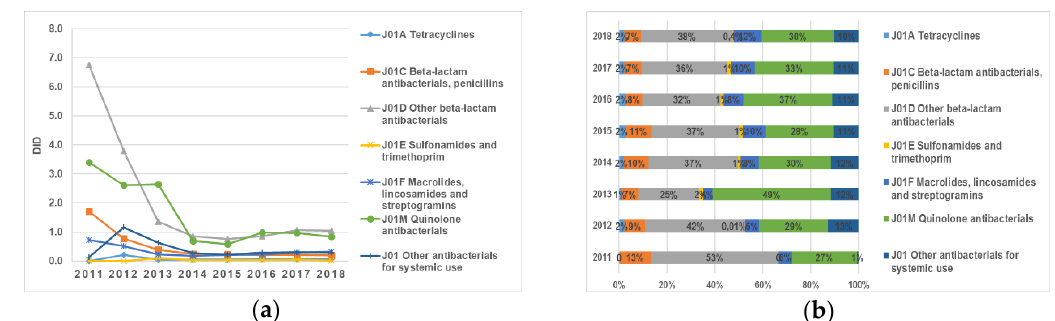
Figure 1. ( a ) Dynamics of changes in antimicrobial consumption according to the route of administration (oral: O; parenteral: P) in Kazakhstan in the period 2011–2018; ( b ) dynamics of changes in the proportion (%) of antimicrobial consumption according to the route of administration (oral: O; parenteral: P) in Kazakhstan in the period from 2011 to 2018.